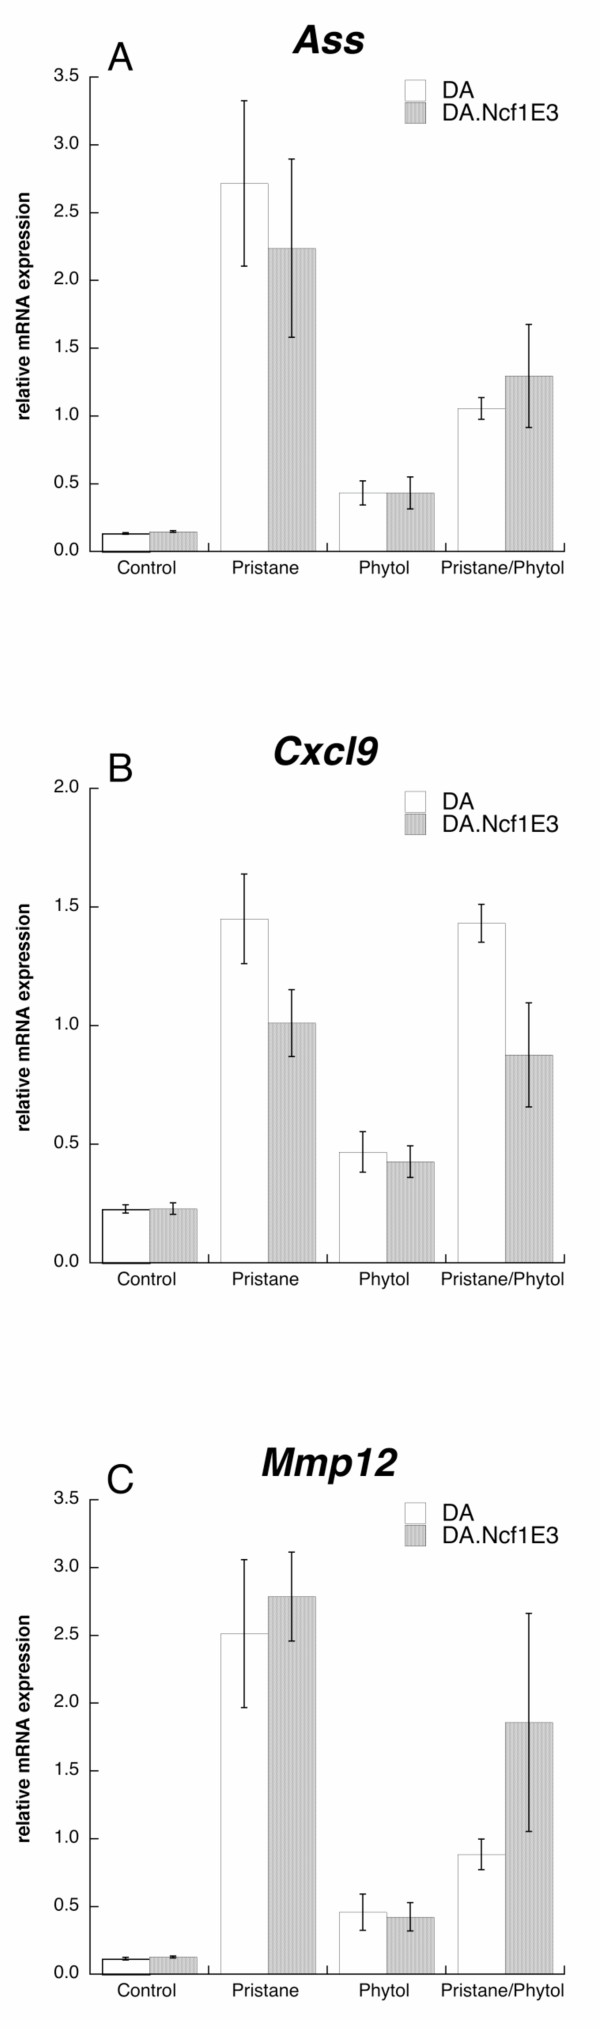
Gene-expression comparison between DA (open bars) and DA. Ncf1E3 (filled bars) of (A) Ass, (B) Cxcl9, and (C) Mmp12 in inguinal lymph nodes 10 days after injection. Values are means ± SEM of 4–5 animals per group. No significant difference between the strains was detected.